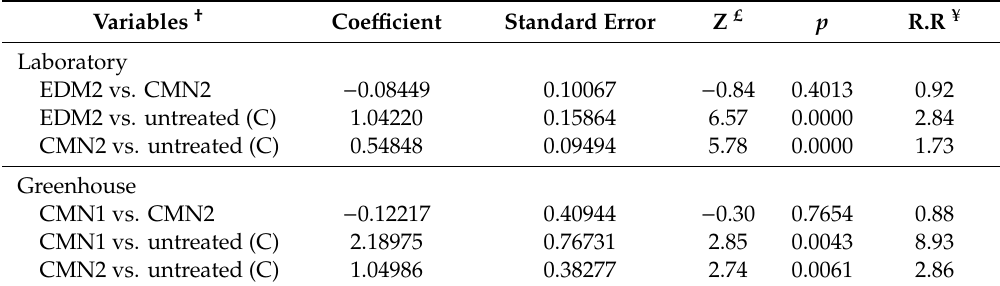
Table 4. Comparing di ff erent treatments in laboratory and greenhouse using Cox’s